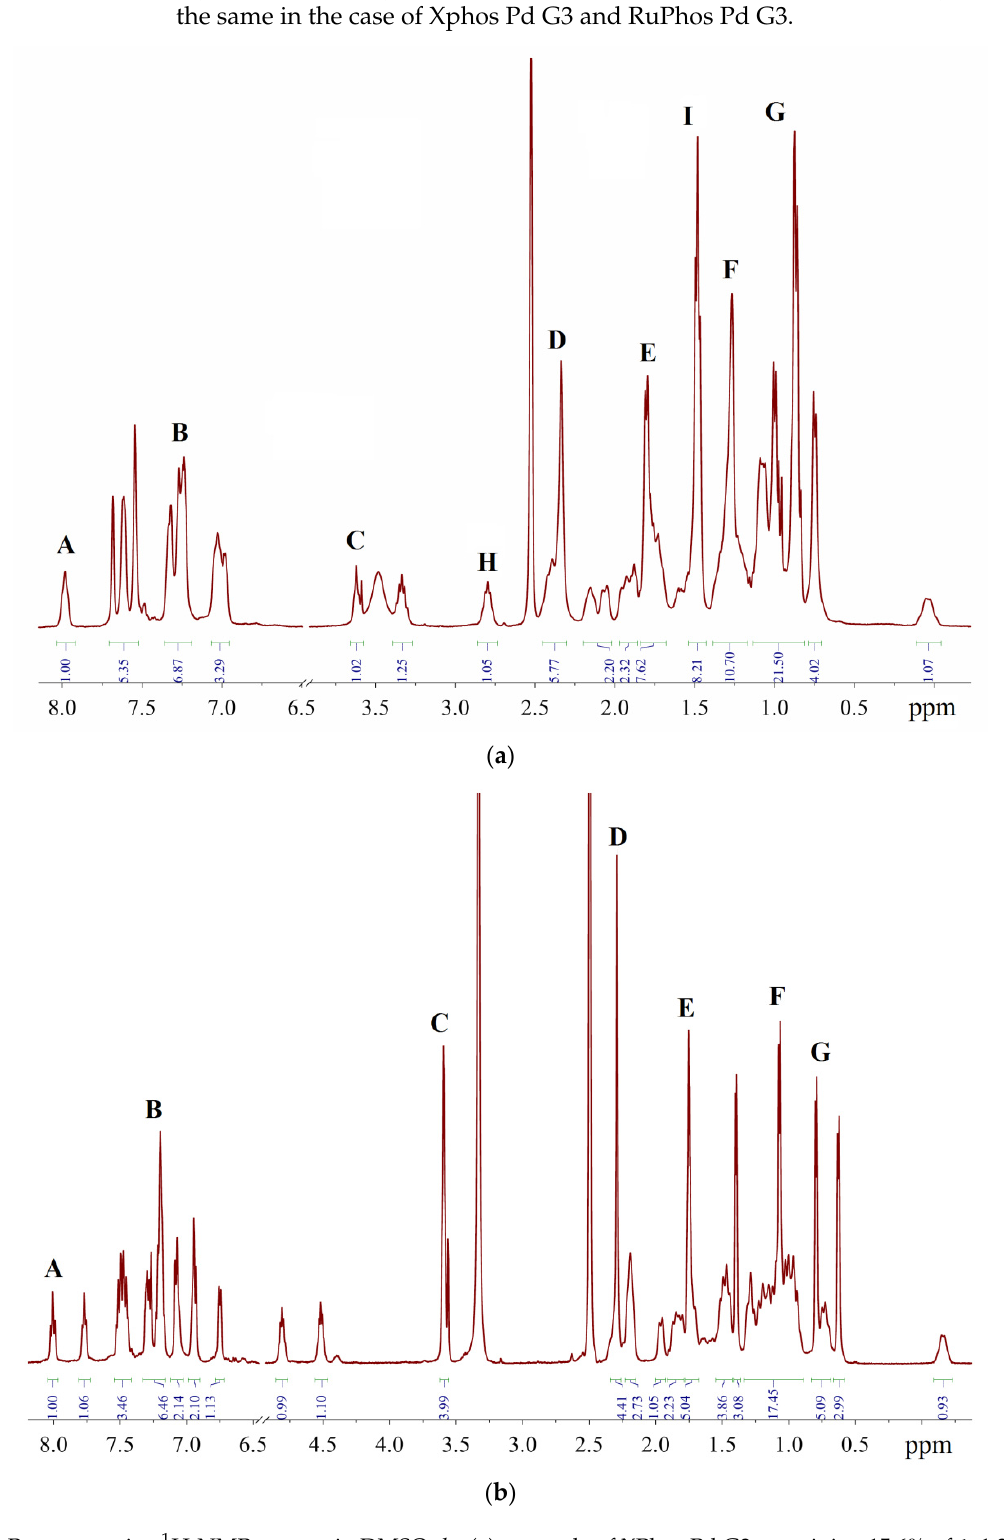
Figure 13. Representative 1 H-NMR spectra in DMSO- d 6 : ( a )—sample of XPhos Pd G3 containing 15.6% of 1 , 1.3% of THF and 4.9% of hexane; ( b )—sample of RuPhos Pd G3 containing 14.1% of 1 , 6.8% of THF and 2.5% of hexane.